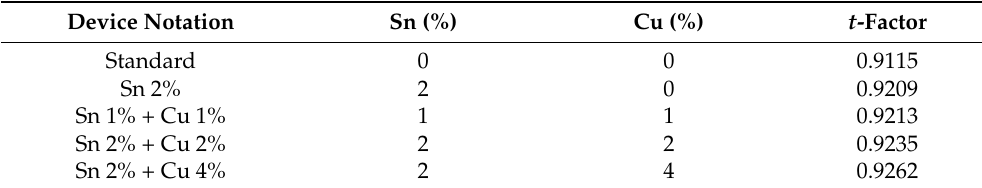
Table 1. Compositions and calculated t -factors of the present MA 0.9 FA 0.1 Pb 1-x-y Sn x Cu y I 3 perovskite